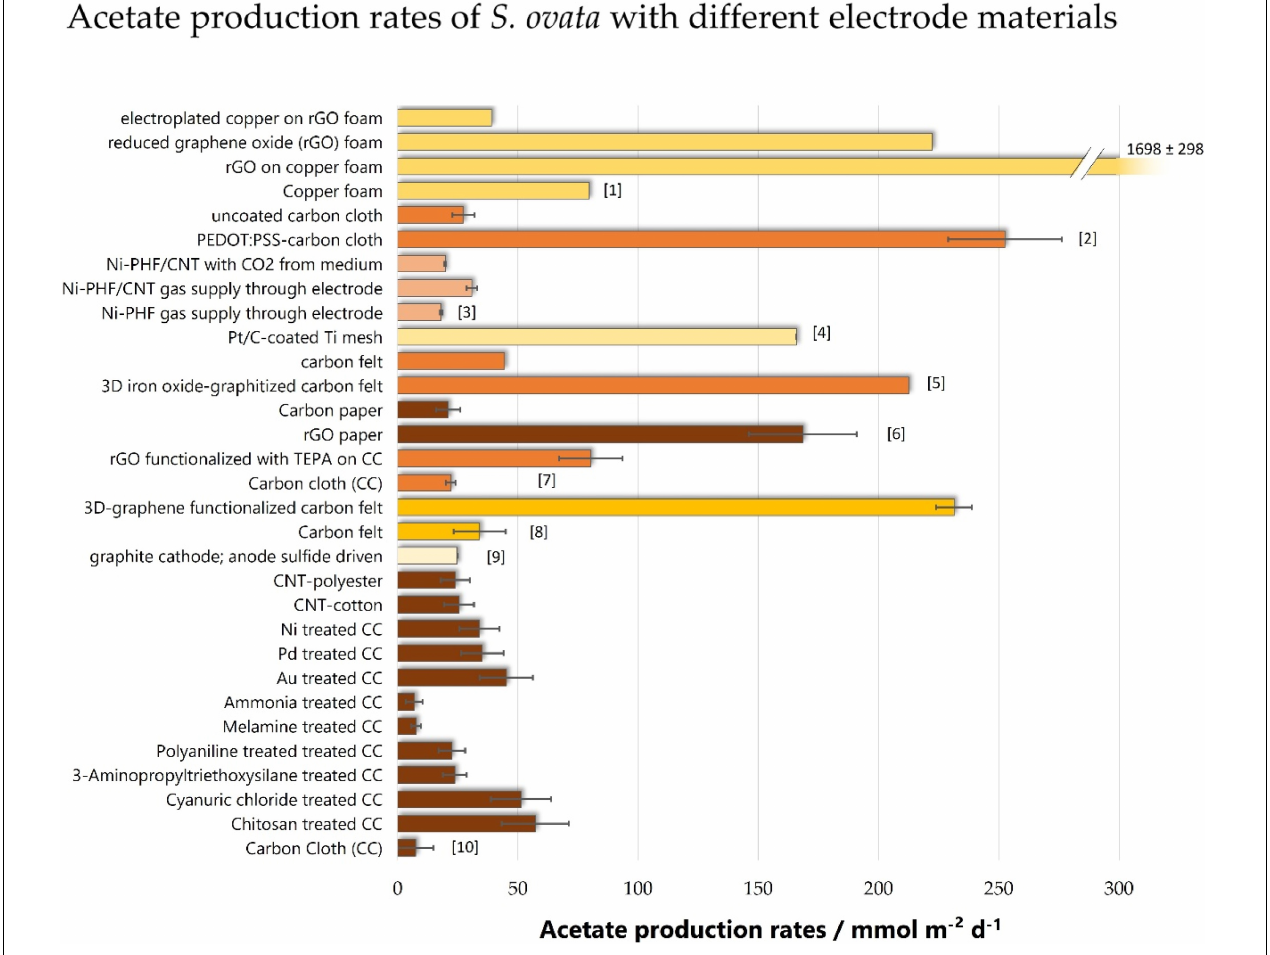
FIGURE 4 | Acetate production rates of S. ovata with different electrode materials. Bars of the same color are derived from the same studies: [1]: (Aryal et al., 2019), [2]: (Aryal et al., 2016), [3]: (Bian et al., 2018), [4]: (Li et al., 2018), [5]: (Cui et al., 2017), [6]: (Aryal et al., 2017a), [7]: (Aryal et al., 2018), [8]: (Aryal et al., 2016), [9]: (Gong et al., 2013), [10]: (Zhang et al., 2013). On that basis, the same color results are directly comparable, as other parameters (cathode potential, medium, temperature, reference for normalization) are equal. rGO, reduced graphene oxide; PEDOT:PSS, poly(3,4-ethylenedioxythiophene:polystyrene sulfonate);